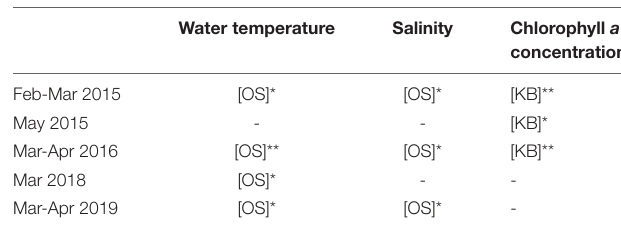
TABLE 1 | Statistical comparison of between the physical and biological environmental parameters in the mouth of Kagoshima Bay and the Osumi Strait by Mann-Whitney U